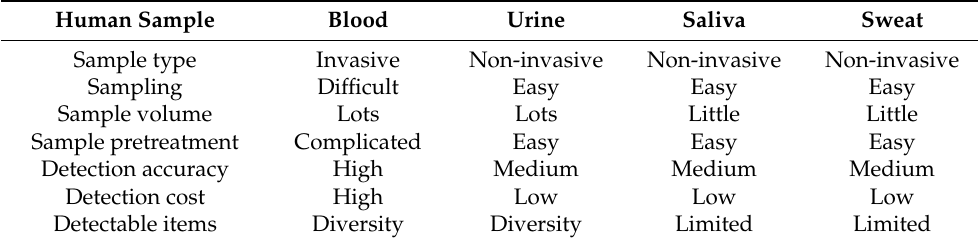
Table 1. Comparison of detection using human